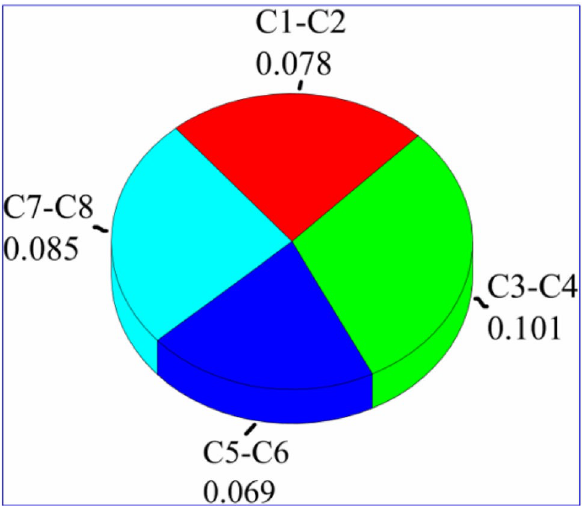
Figure 3. 3-D color Pie chart of the average difference of RMSE for 1 H-NMR chemical shifts.